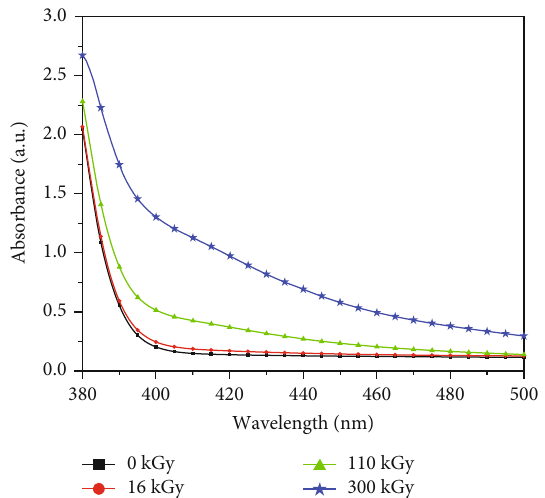
Figure 1: The spectra of optical absorption UHMWPE polymer at 0kGy, 16kGy, 110 kGy, and 300kGy radiation doses.